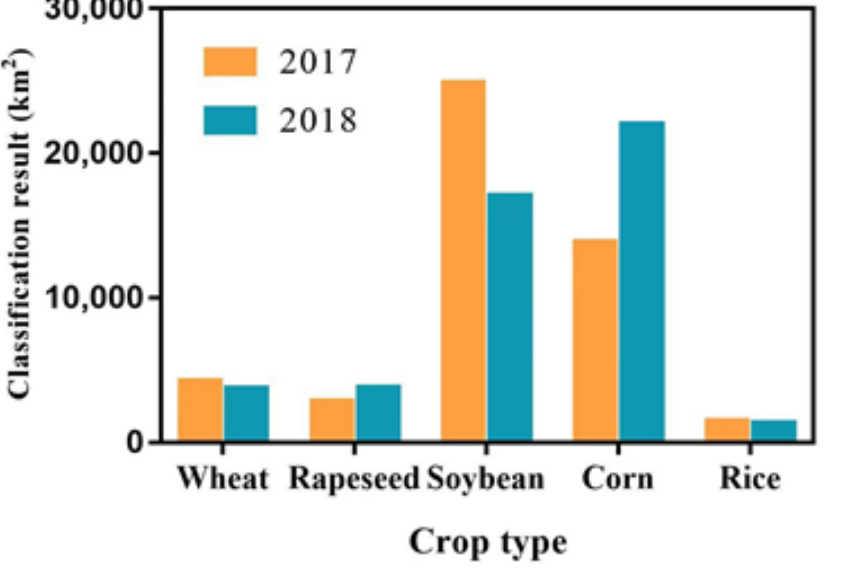
Figure 9. Total areas of different crop types in 2017 and 2018, based on the classification results.